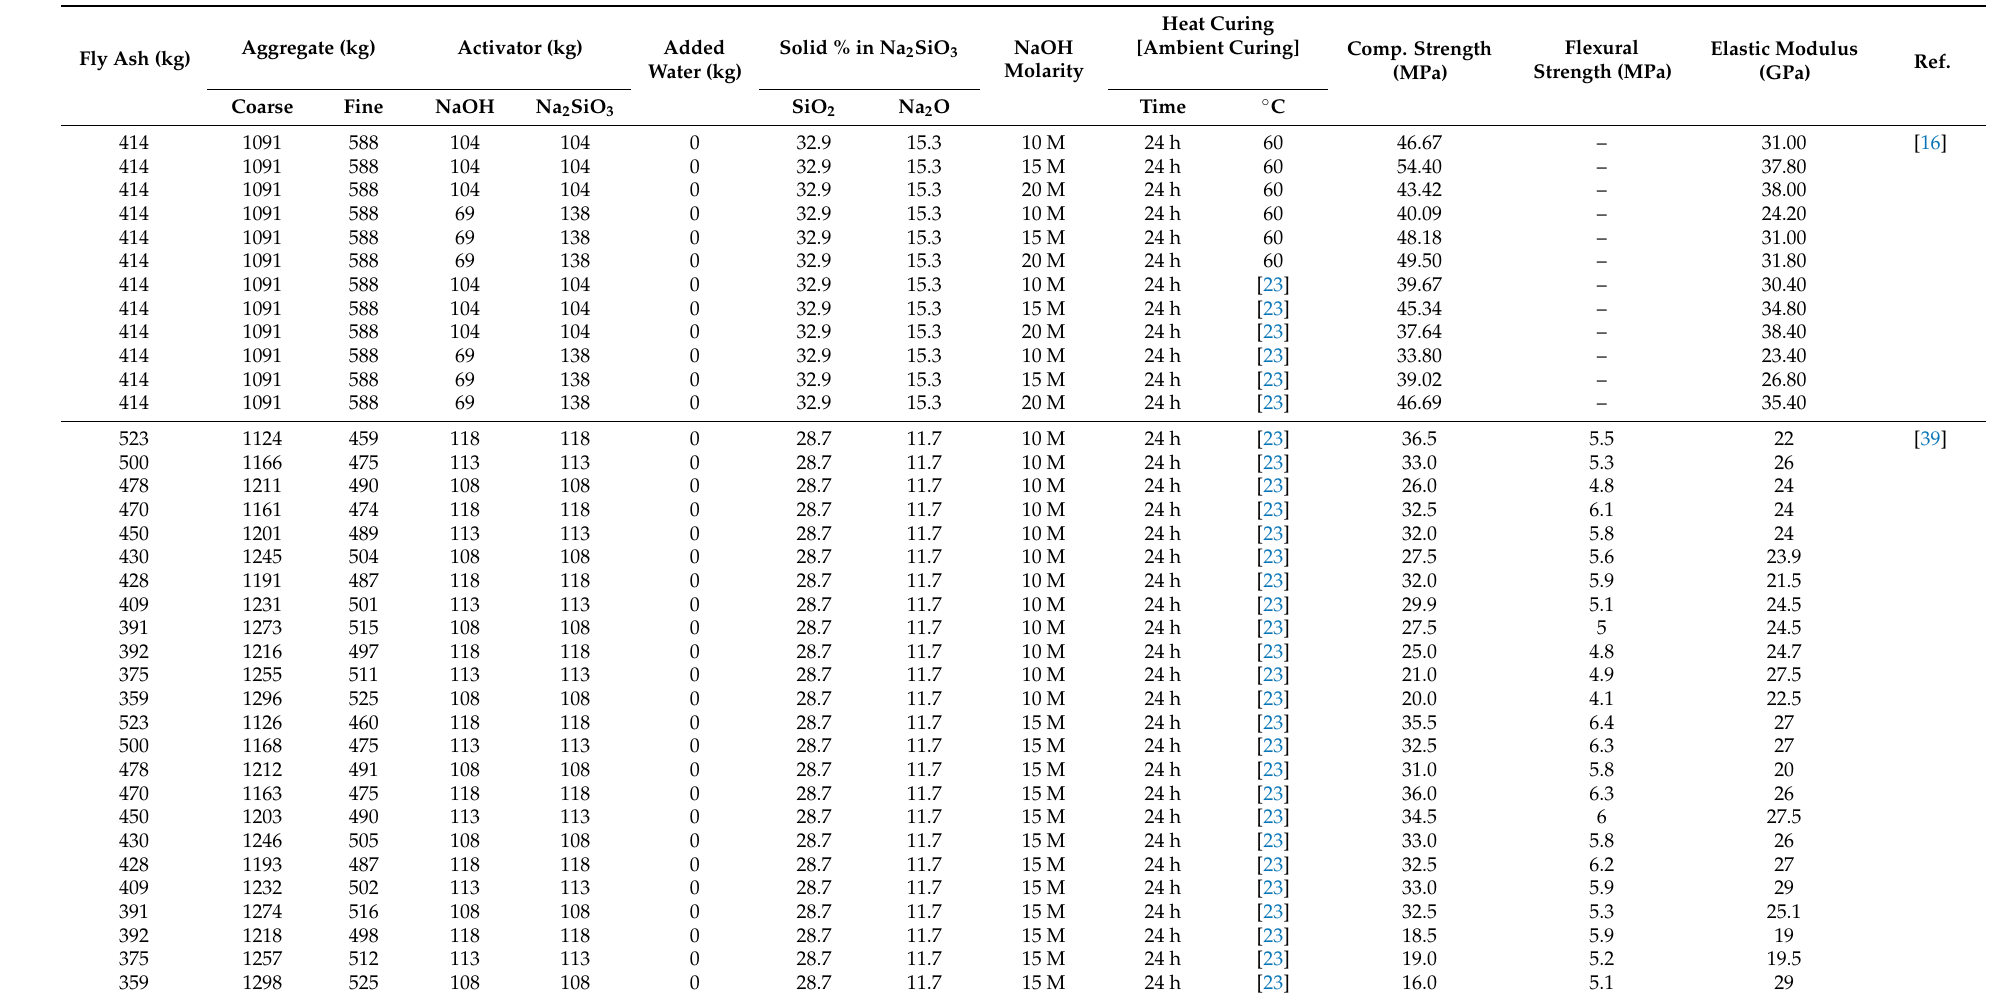
Table 1. Mix design database for high calcium fly ash geopolymer